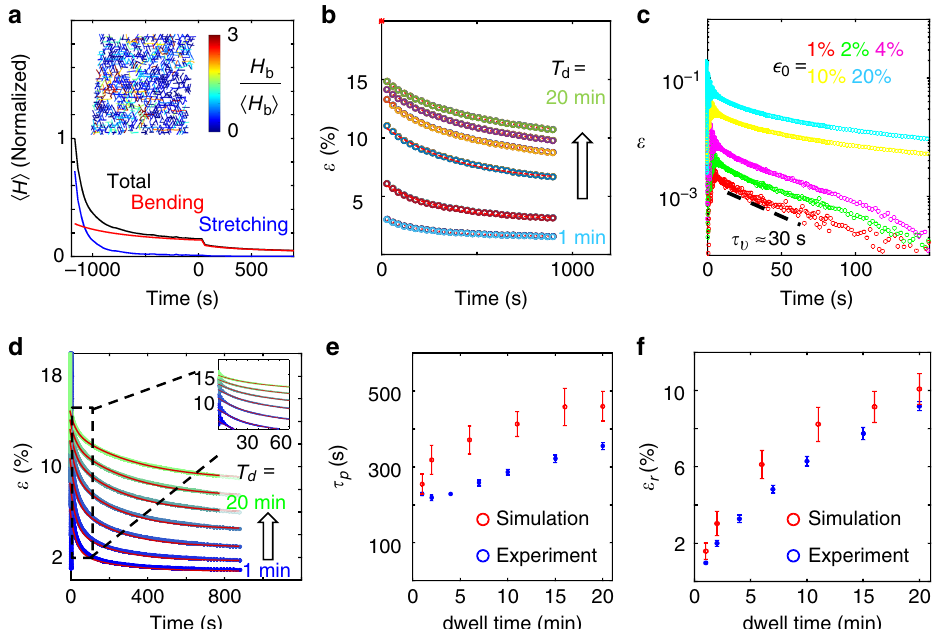
Fig. 3 Bulk relaxation kinetics of collagen matrices. a The normalized elastic energy per fi ber 〈 H 〉 over the course of relaxation of a model network. Black: sum of bending and stretching energy. Red: bending energy. Blue: stretching energy. All three curves are normalized by the total energy per fi ber at t = − 20 min. The network is sheared to 20% at t = − 20 min, and released at t = 0. Inset: The network con fi guration after 20 min of relaxation ( t = 1200 s). The fi bers are color-coded according to the bending energy per unit length of each fi ber H b , normalized by the ensemble average 〈 H b 〉 . b Simulated strain decay kinetics with 20% initial strain and varying dwell times T d = 1, 2, 6, 10, 16, and 20 min. The dashed lines are fi ts to a single exponential. c Experiments show strain relaxation kinetics ε ( t ) − ε ( ∞ ) depend on the initial strain, and at small initial strains, the relaxation follows a single exponential function. Here ε ( ∞ ) is approximated by the strain measured after 15 min of relaxation, Supplementary Fig. 16 for results with extended relaxation time. d Experiments show strain relaxation kinetics depends on the dwell time T d . Colors of the symbols (blue to green) correspond to the increasing dwell time of 1, 2, 4, 7, 10, 15, and 20 min. Red lines are fi t to double-exponential functions ε ( t ) = a exp( − t / τ v ) + b exp( − t / τ p ) + ε r . Here τ v is independent of dwell time T d , τ p , and ε r are allowed to vary with T d . Inset: zoom-in to the initial phase of the relaxation. e The plastic time scale τ p as a function of dwell time T m . f The residual strain ε r as a function of dwell time T d . Error bars in e , f are means and standard deviations from eight different